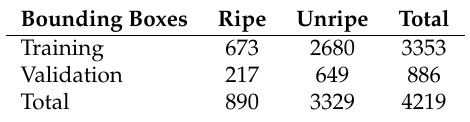
Table 3. Distribution of labelled classes across training and testing sets for V 1 , V 2 and V 3 . Bounding